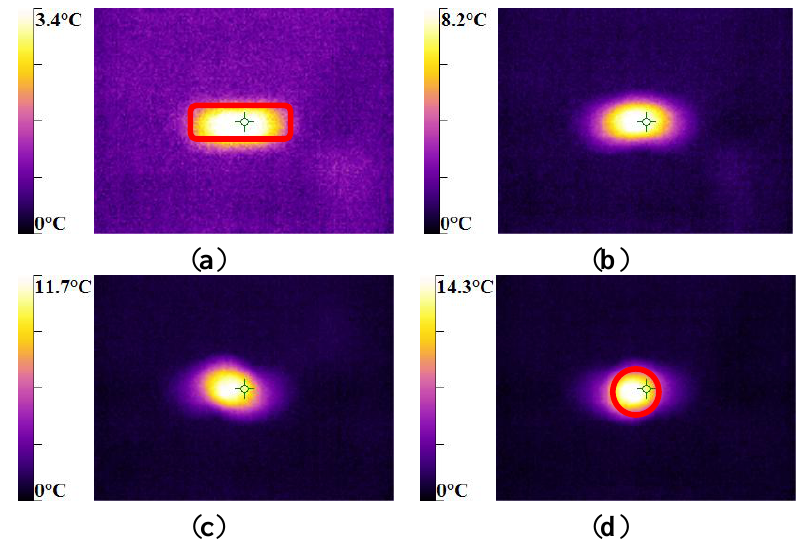
Figure 20. IR Thermographs of PA66 torsion test for V = 12 rad/min. ( a ) γ = 0.73 rad; ( b ) γ = 1.18 rad; ( c ) γ = 1.39 rad; and ( d ) γ = 1.86 rad.